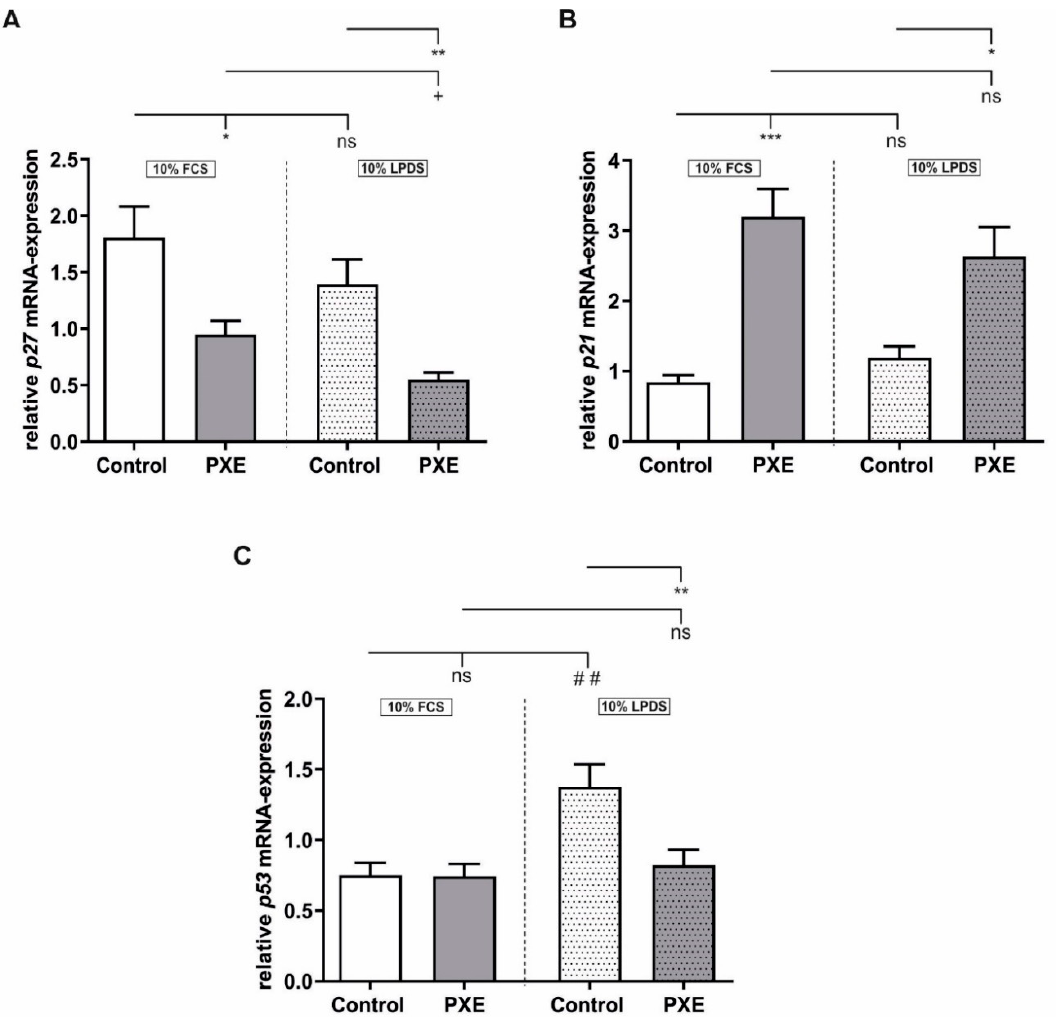
Figure 3. Relative p27, p21 und p53 mRNA-expression of PXE fibroblasts and NHDF. Fibroblasts were cultivated for 24 h in medium with 10% FCS or 10% LPDS. ( A ) Relative p27 mRNA-expression of PXE fibroblasts (gray, n = 3) and NHDF (white, n = 3). ( B ) Relative p21 mRNA-expression of PXE fibroblasts (gray, n = 3) and NHDF (white, n = 3). ( C ) Relative p53 mRNA-expression of PXE fibroblasts (gray, n = 3) and NHDF (white, n = 3). Data are shown as mean ± SEM. Control / PXE: * p ≤ 0.05; ** p ≤ 0.01; *** p ≤ 0.001; ns p > 0.05. 10% FCS / 10% LPDS: + p ≤ 0.05; ## p ≤ 0.01; ns p > 0.05.